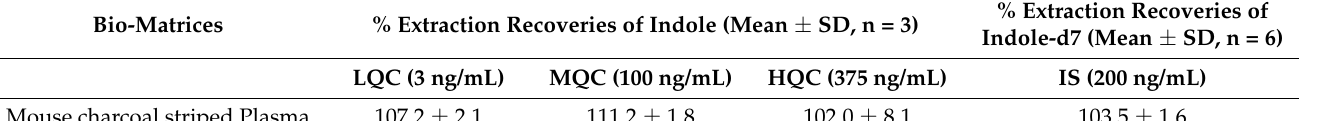
Table 2. Mean extraction recoveries of indole and indole-d7 in mouse charcoal striped plasma, mouse serum and mouse lungs.